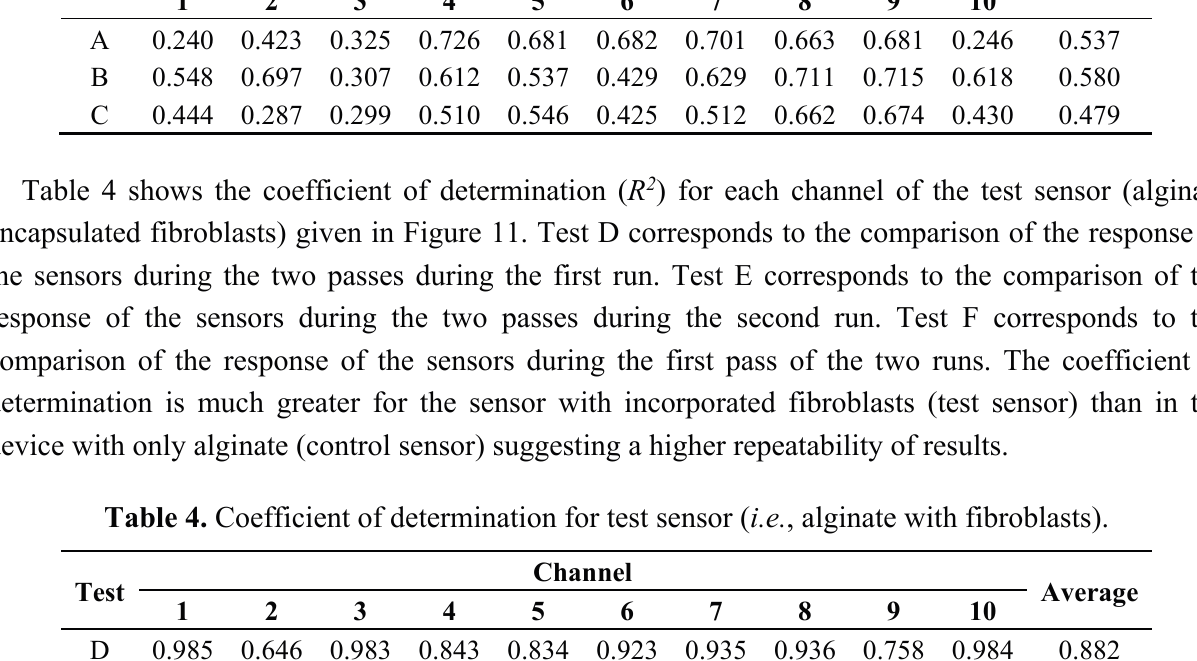
Table 3. Coefficient of determination for control sensor ( i.e. , alginate only). Test